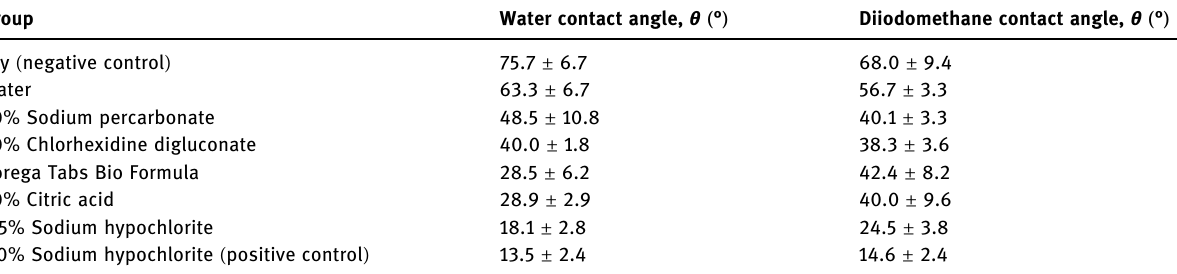
Table 8: Contact angle of water and diodomethane ( mean with standard deviation ) on Co – Cr surface after conditioning in dental cleaners Group